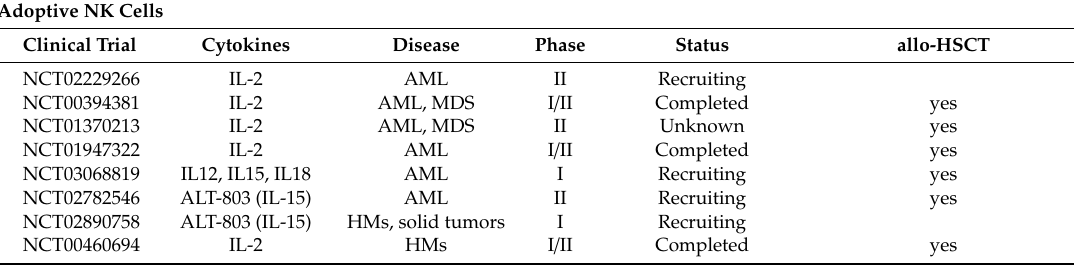
Table 1. Selected list of clinical trials in NK cell-based